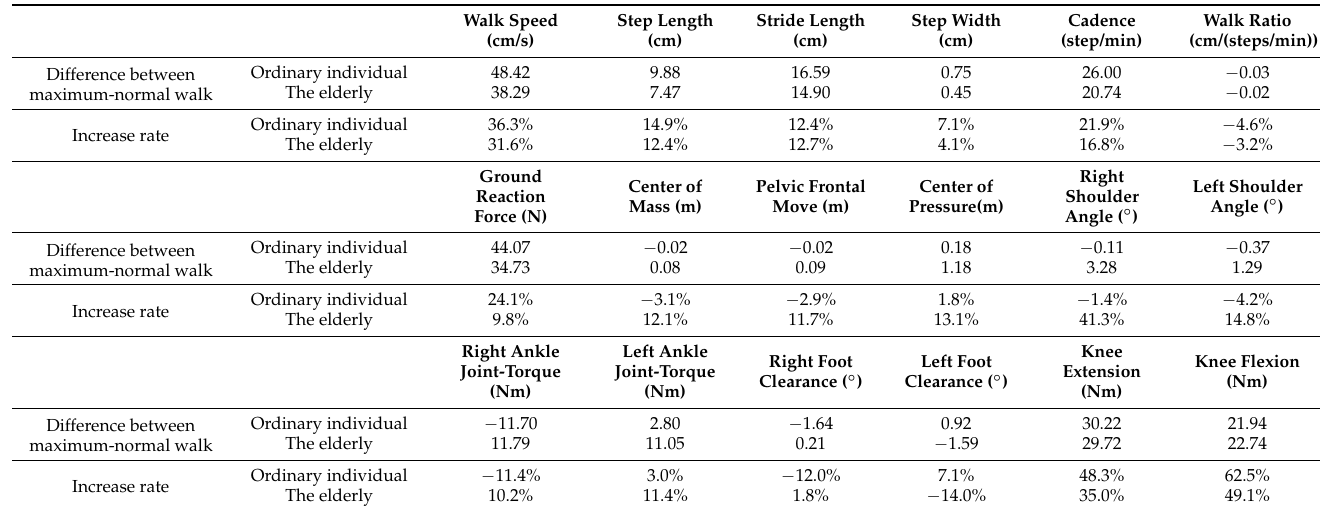
Table 11. Comparison of differences between normal walking and maximum walking.